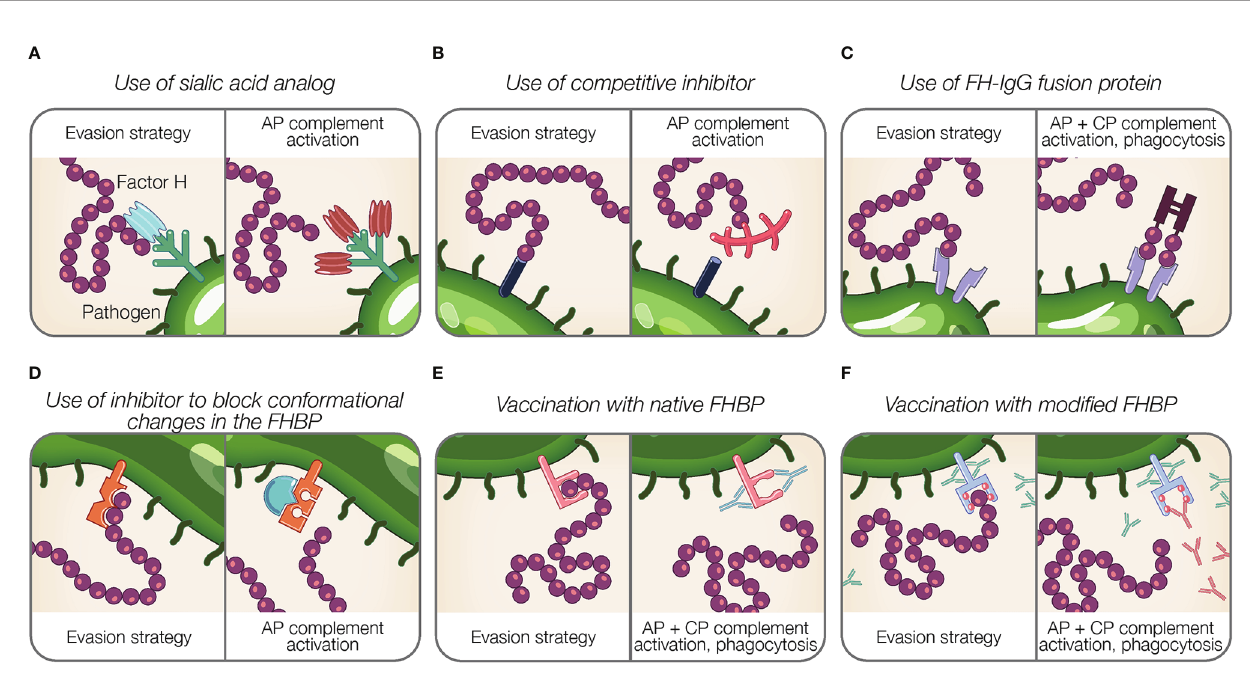
FIGURE 4 | Potential therapeutic and preventive strategies targeting the interaction between Factor H and pathogens. (A – F) Theoretical representations of pathogen evasion strategies targeted for therapy and prevention are shown. For each box, the left panel illustrates a pathogen evasion strategy and the right panel represents the intended result of therapeutic intervention, which includes AP and CP activation, and phagocytosis. (A) Sialic acid species (shown in light blue) are replaced by analogs unable to recognize FH (shown in brown). (B) Competitive inhibitors for FH binding proteins (FHBP) prevent FH interaction with the pathogen surface. (C) FH fusion proteins containing the Fc portion of IgG fused to FH binding fragments (CCPs 6 – 7, 19 – 20) bind FHBP to activate the CP via antibody recognition, facilitate Fc g receptor-mediated phagocytosis, and prevent FH binding to the pathogen surface. (D) Inhibitors prevent conformational change of FHBP required to enhance their binding to FH. (E) Vaccination with native FHBP. (F) Vaccination with modi fi ed FHBP unable to bind FH, reveals FHBP epitopes (red balls) to improve